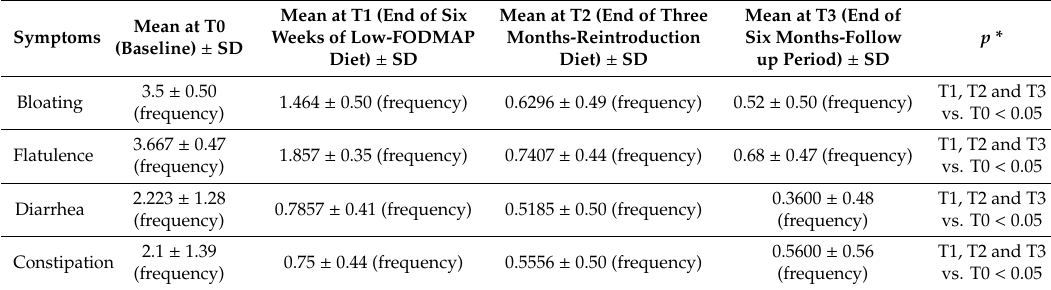
Table 4. Frequency of analyzed symptoms at T0, T1, T2, and T3.